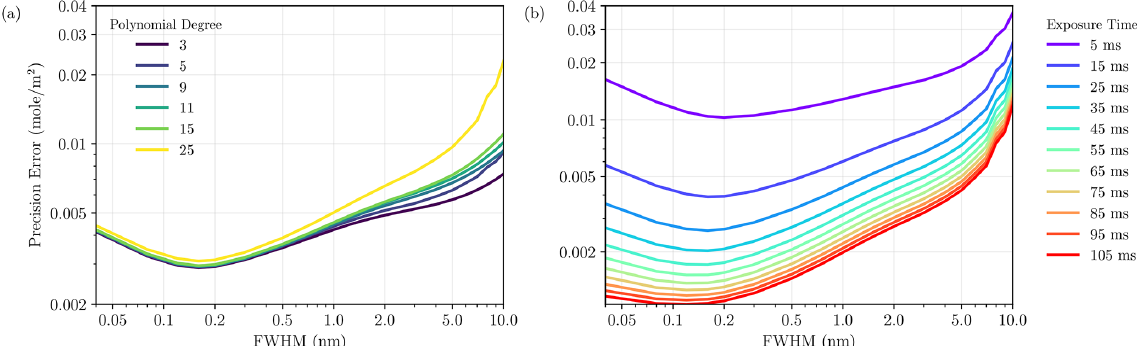
Figure 10. (a) Precision error as a function of instrument FWHM for different numbers of polynomial degrees used in the retrieval (with an exposure time of 20ms). (b) Precision error as a function of instrument FWHM for different exposure times (with a polynomial degree of